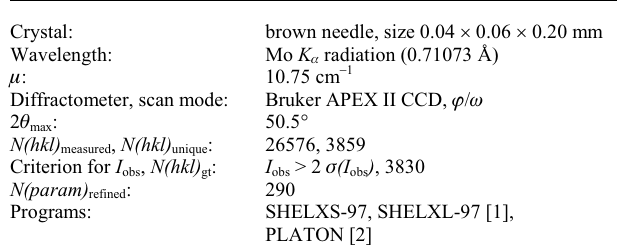
Table 1. Data collection and handling.